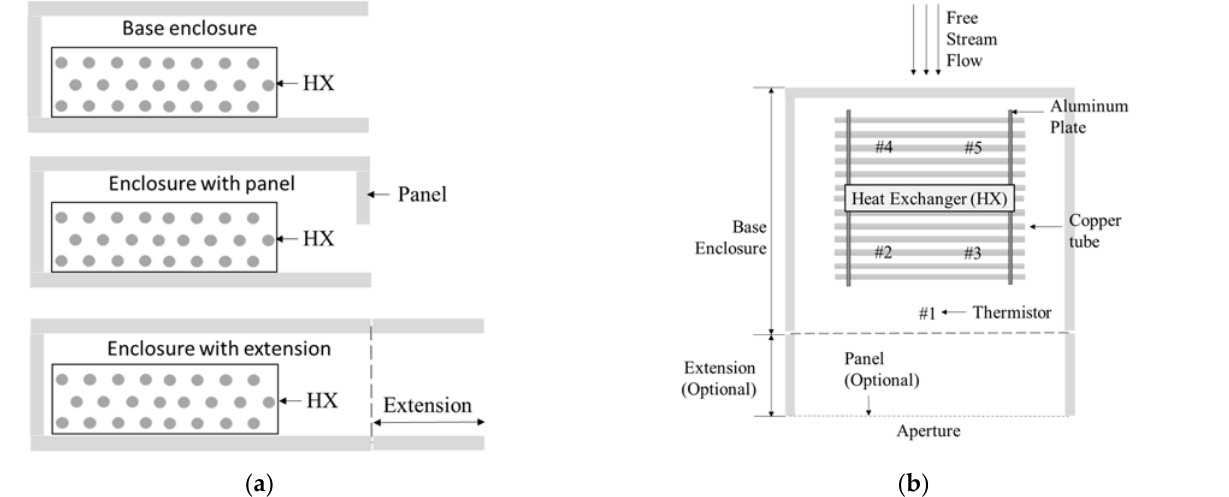
Figure 4. Schematic of ( a ) side view of the enclosure showing the heat exchanger, panel, and extension, ( b ) the top view of the heat exchanger and enclosure configuration with thermistor locations (figure not drawn to scale).